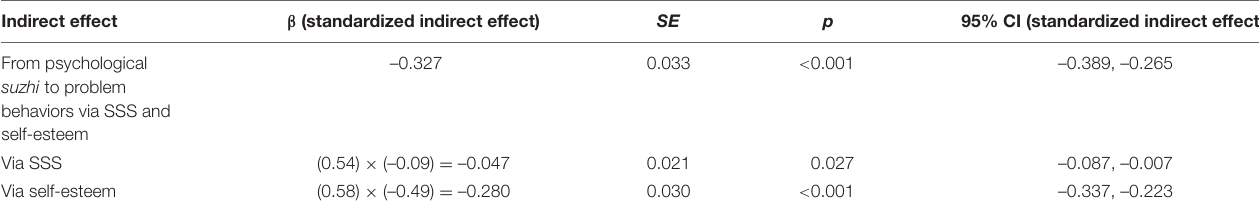
TABLE 2 | Standardized indirect effects from psychological suzhi to problem